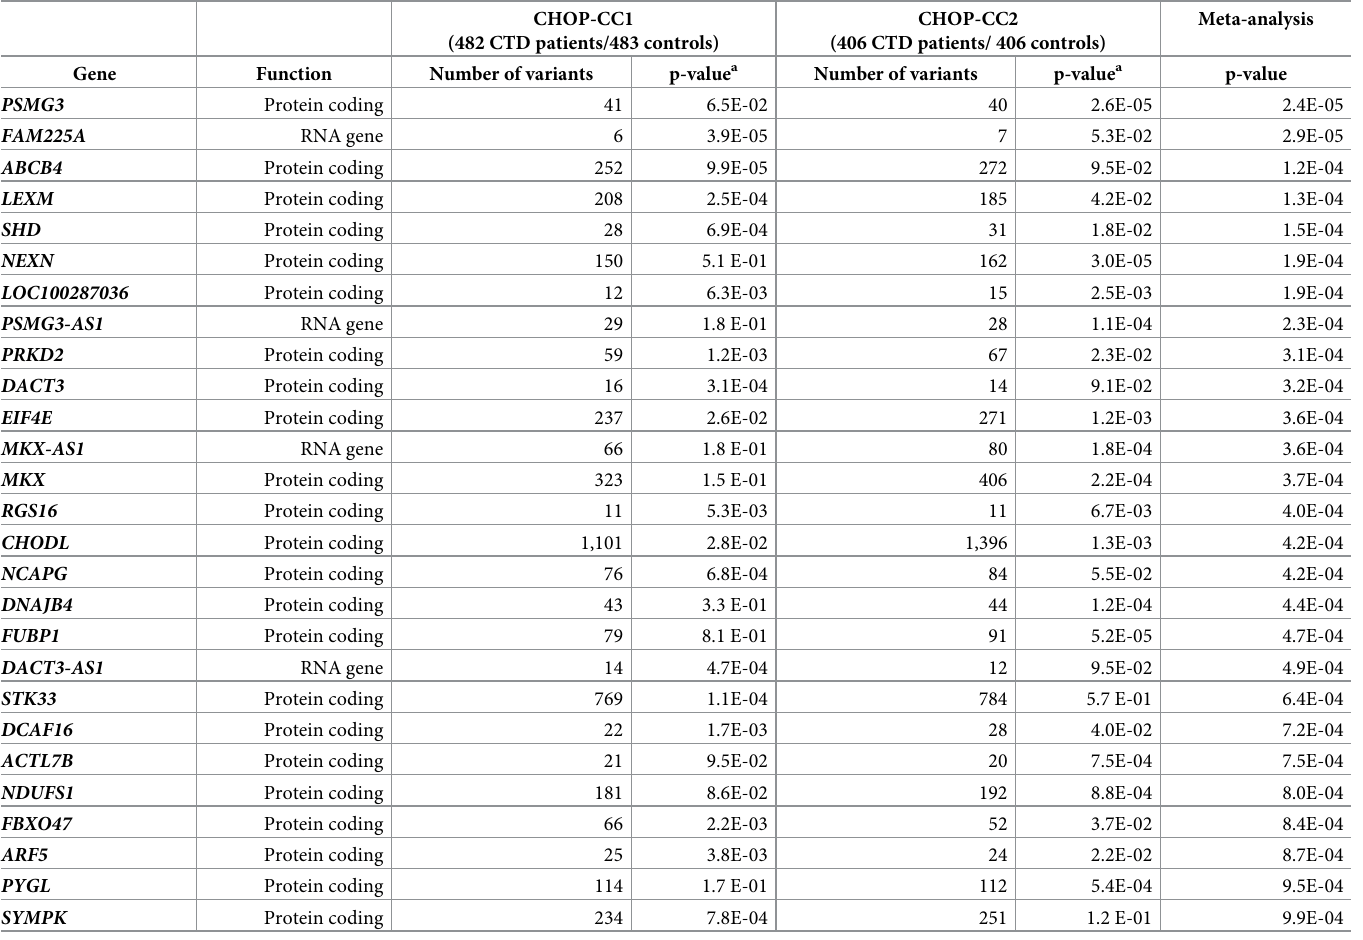
Table 4. Genes with suggestive evidence of association (p < 1E-03) in the case-control based meta-analysis.